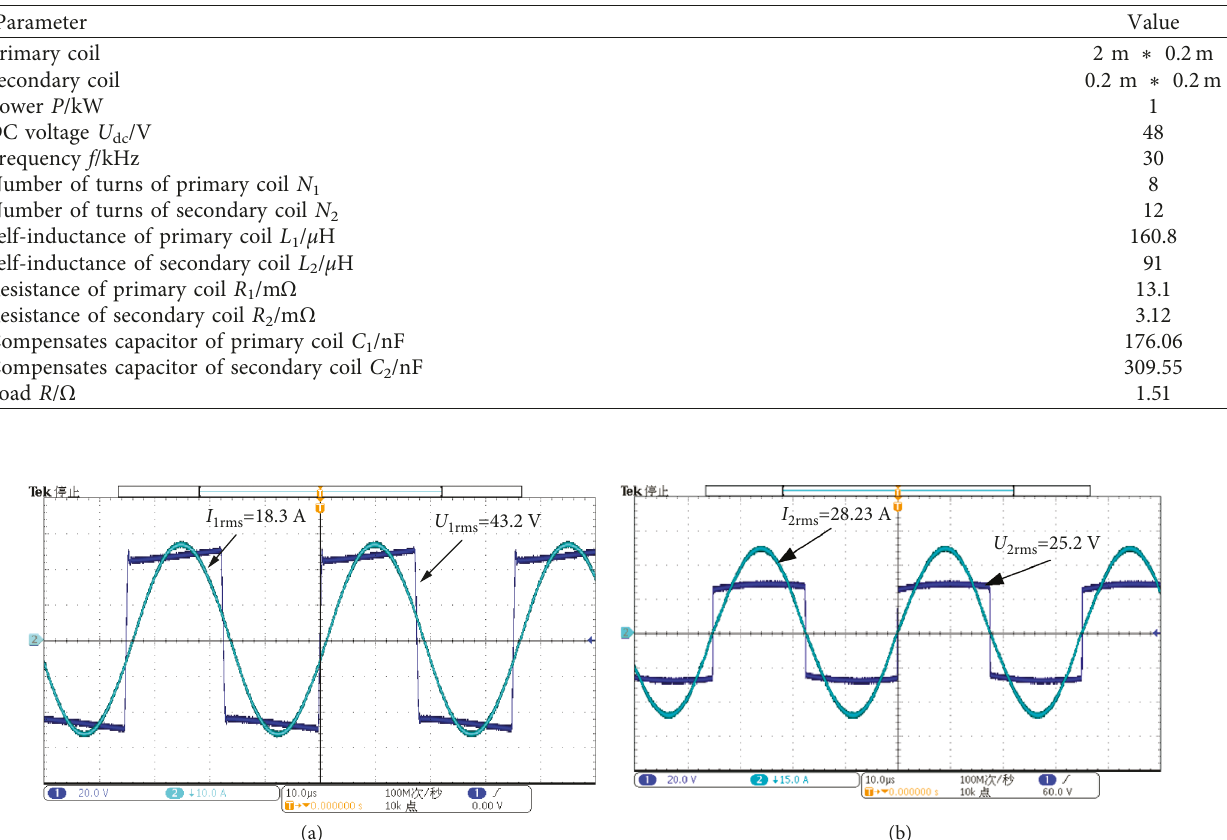
Figure 12: Experiment platform. Table 5: System parameters.